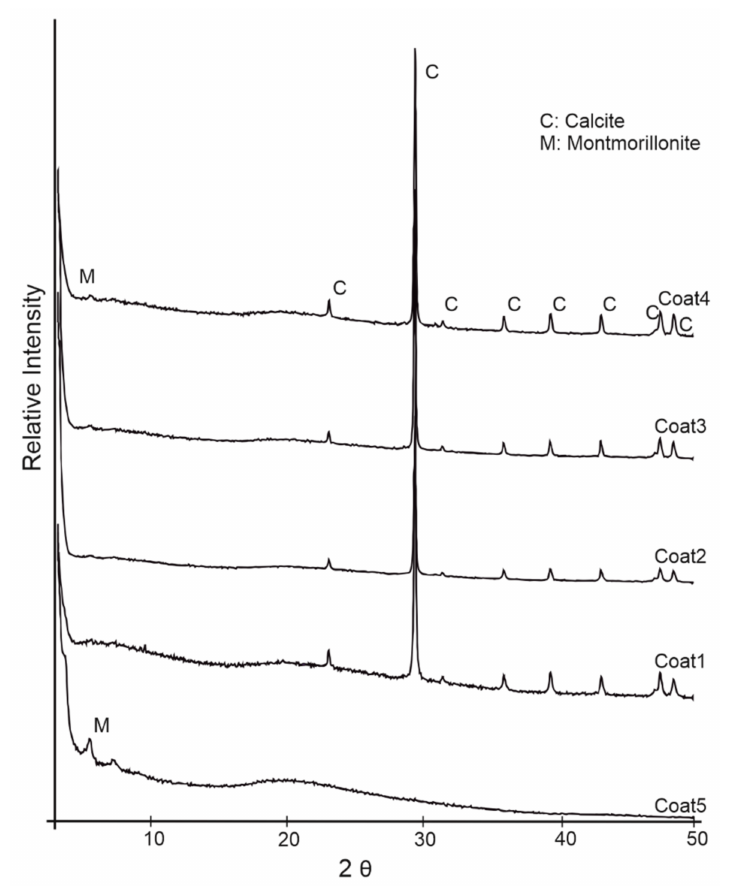
Figure 2. XRD patterns of